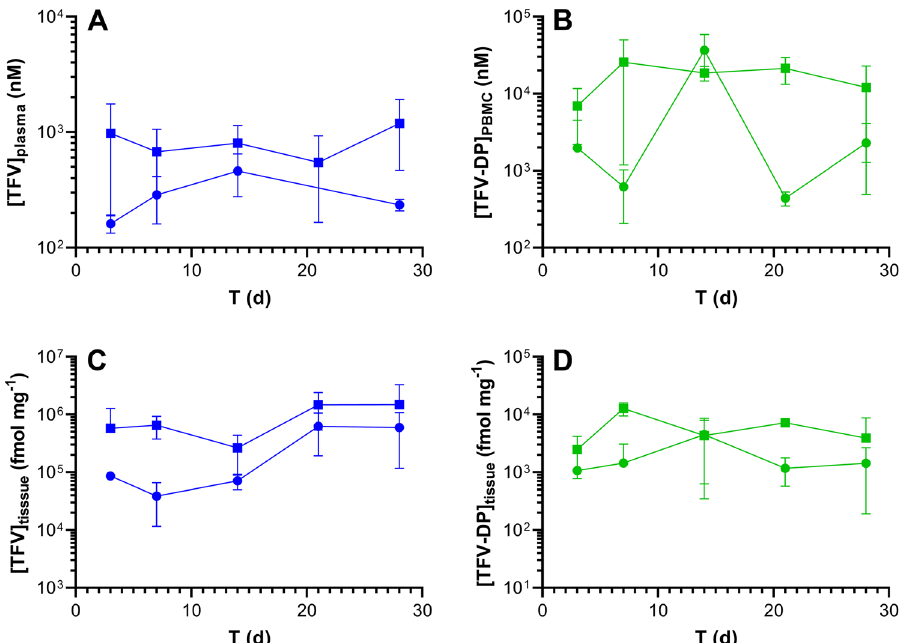
Figure 5. Subdermal placement of TAF implants in C57BL/6 J mice maintains sustained drug concentrations. Data are presented as means ± SD ( N = 3 per timepoint); circles, low-releasing implants (0.28 mg d -1 in vivo); squares, high-releasing implants (0.58 mg d -1 in vivo). Pharmacokinetic profiles of ( A ) plasma TFV; ( B ) PBMC TFV-DP; ( C ) dermal tissue (collected adjacent to the implant) TFV; and ( D ) dermal tissue TFV-DP. The assay LLOQs are: plasma TFV, 3.5 nM (1 ng mL -1 ); PBMC TFV-DP, 13 nM (based on 5 fmol/sample, and a median of 1.9 × 10 6 PBMCs per sample); tissue TFV 21 fmol mg -1 (based on 0.05 ng/sample, and a median of 8.4 mg per sample); tissue TFV-DP 0.6 fmol mg -1 (based on 5 fmol/sample, and a median of 8.4 mg per sample).